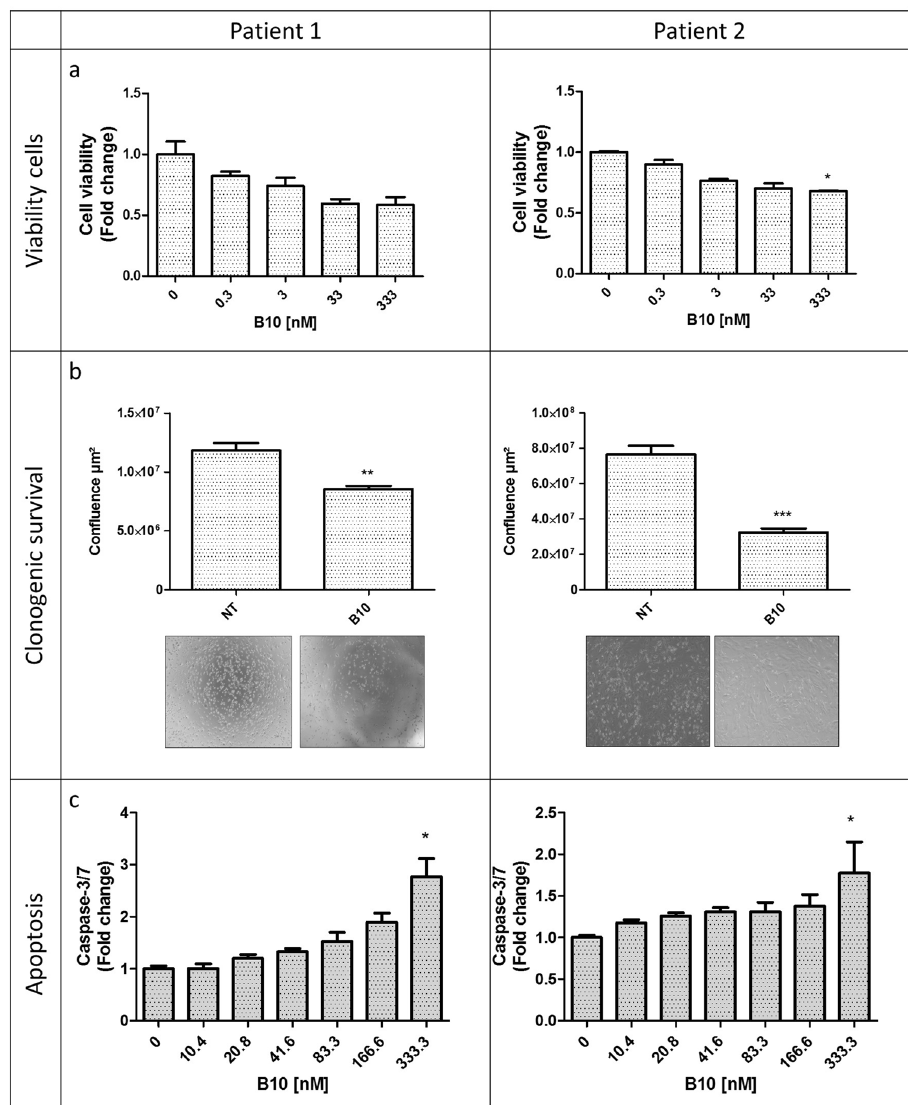
Figure 3. The anti-AMH antibody B10 reduces cell viability/proliferation and induces growth inhibition in tumor cells from ovarian carcinoma ascites samples. ( a ) Cell viability analyzed with the MTS assay after incubation with 0.3 to 333 nM B10 for 3 days. ( b ) Cell growth inhibition (cell confluence measured with the Celigo Imaging System) after incubation or not (NT) with 70 nM B10 for 48 h. ( c ) Apoptosis induction